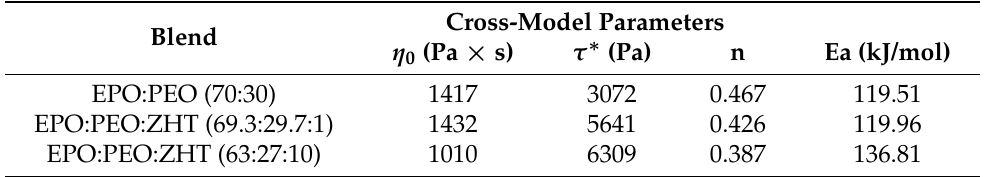
Table 4. Cross-model parameters and Arrhenius activation energy of flow (kJ/mol) for the placebo and drug-loaded